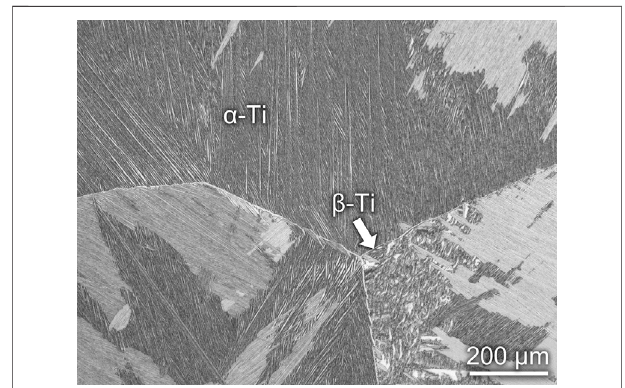
FIGURE 2 | Optical image of the microstructure of as-cast Ti-6Al-4V.